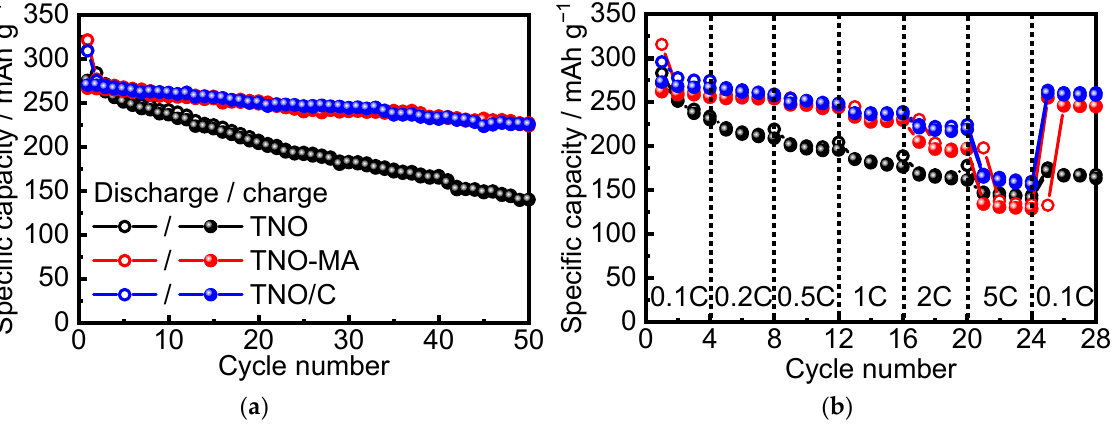
Figure 7. Discharge–charge capacity vs. ( a ) cycle number at C/10 and ( b ) cycling rate in the 1.0–3.0 V range for TNO, TNO-MA, TNO/C.